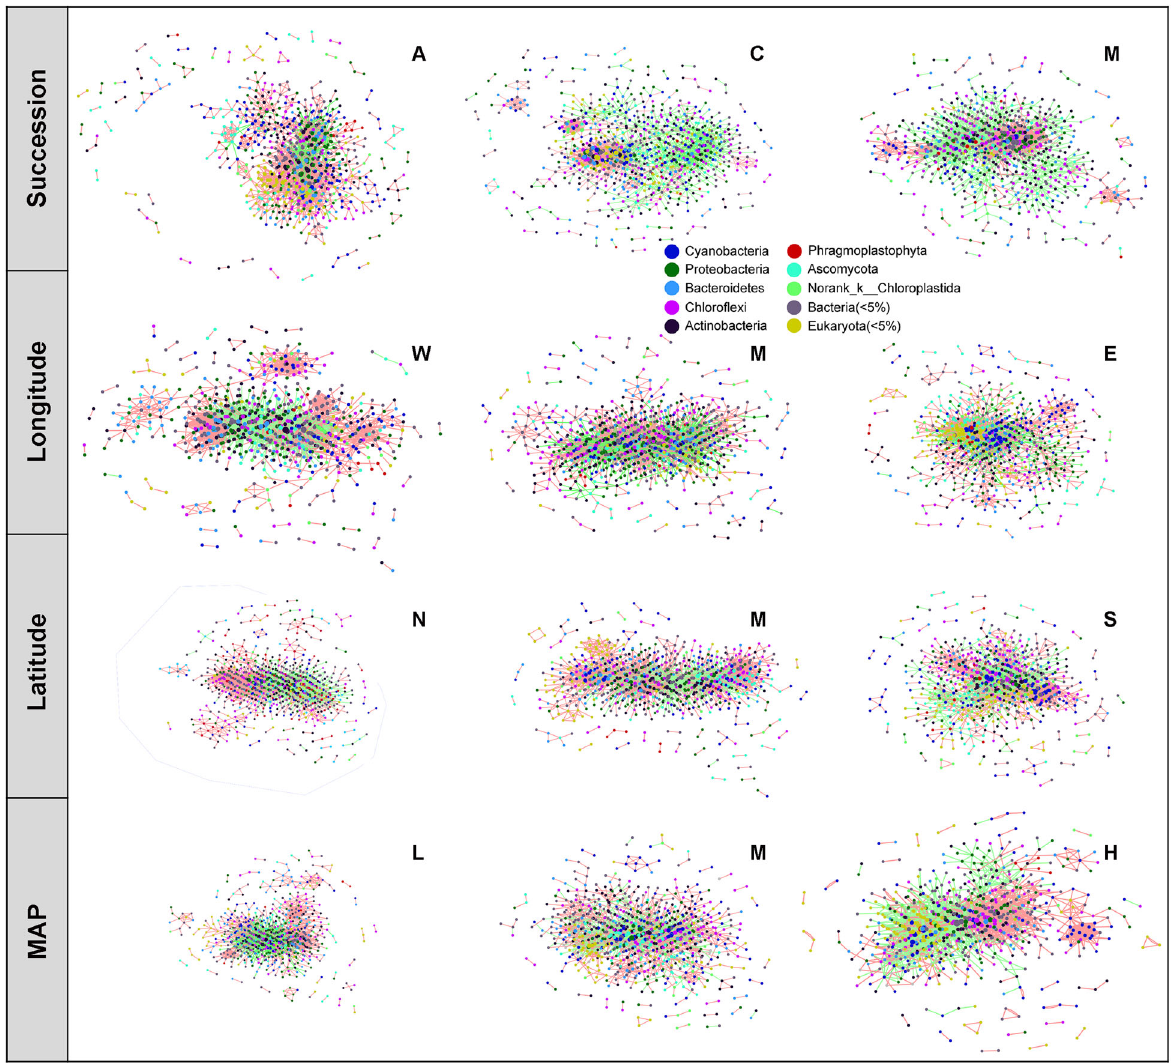
Fig. 4 Co-occurrence network of microbiomes based on succession, longitude, latitude, and mean annual precipitation (MAP) study angles. Each study angles was partitioned into three groups, algae-dominated crust (A), lichen-dominated crust (C), and moss-dominated crust (M) for succession; West (W), Mid-longitude (M), East (E) for longitude; North (N), Mid-latitude (M), and South (S) for latitude; Low-MAP (L), Mid-MAP (M), and High-MAP (H) for MAP, respectively. The size of each node was proportional to the degree of the operational taxonomic units. Node color was based on phylum taxa. The connection (edge) colored with red and green represented coexistence and mutual exclusion, respectively. See Table 2 and Supplementary Table 4 for more detailed topological